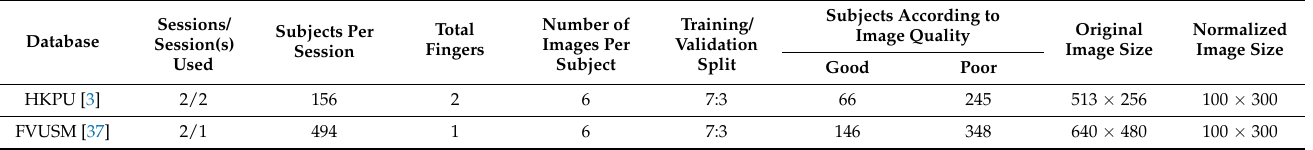
Figure 4. ( a ) Good quality HKPU. ( b ) Poor quality HKPU. ( c ) Good quality FVUSM and ( d ) Poor quality FVUSM. Table 3. Details about the Publicly Available Finger Vein Image Databases used in this Research.